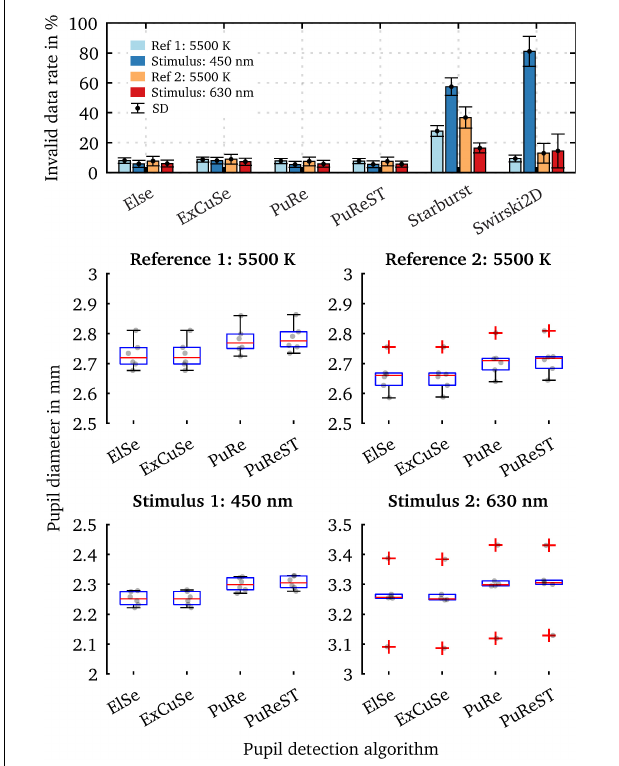
FIGURE 10 | Percentage of invalid pupil fits inside the raw data, and the averaged steady-state pupil diameter of the last 5 s. Pupil data are from one subject with six repetitions in each condition. (A) Mean of the invalid data point count (outline confidence < 1) in per cent for each algorithm and used spectrum. A higher invalid data rate indicates that more raw data need to be removed due to inaccurate pupil fits. The Starburst algorithm did not provide an adequate detection rate, mainly observed at 450 nm (57.46% ± SD 5.93%) and the second reference spectrum (36.82% ± SD 7.1%). The Swirski algorithm showed a significant invalid detection rate of 81.09% ± SD 10.10% at 450 nm. Since the cameras were equipped with an IR-high-pass filter, the spectral-dependent pupil detection rate is mainly due to the differently sized pupil diameter. Due to the increased number of parameters from Starburst and Swirski , a generalization for small and large pupil diameters is more challenging. (B) The temporal pupil diameter was averaged over the last 5 s to compare how differently the pupil algorithms evaluate the same dataset. The ElSe and ExCuSe algorithms have approximately the same pupil diameter in all scenarios, which is due to the computation method’s similarities. The same applies to the PuRe and PuReST algorithms. The measured pupil diameter’s uncertainty range is on average 0.05 mm ± SD 0.004 mm, originating from the different detection results with the same dataset.